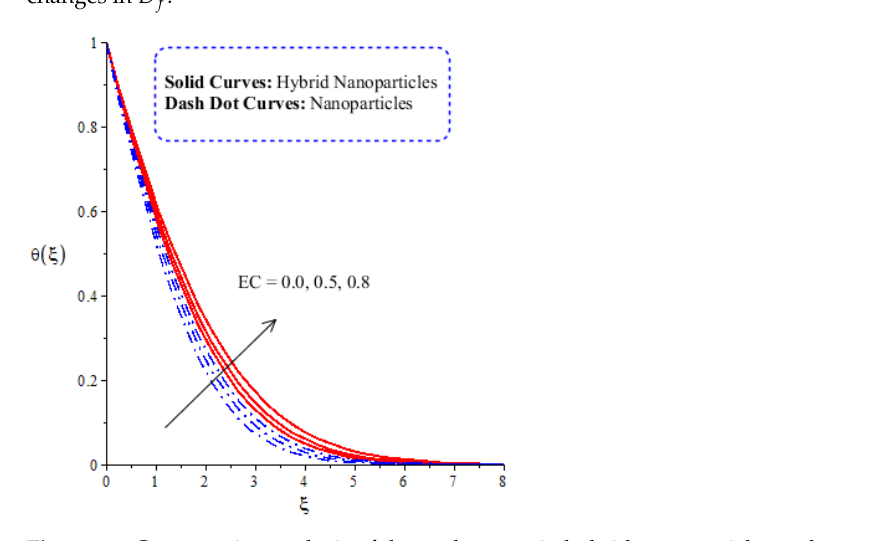
Figure 12. Comparative analysis of thermal energy in hybrid nanoparticles and nanoparticles with changes in 𝐸𝐶.